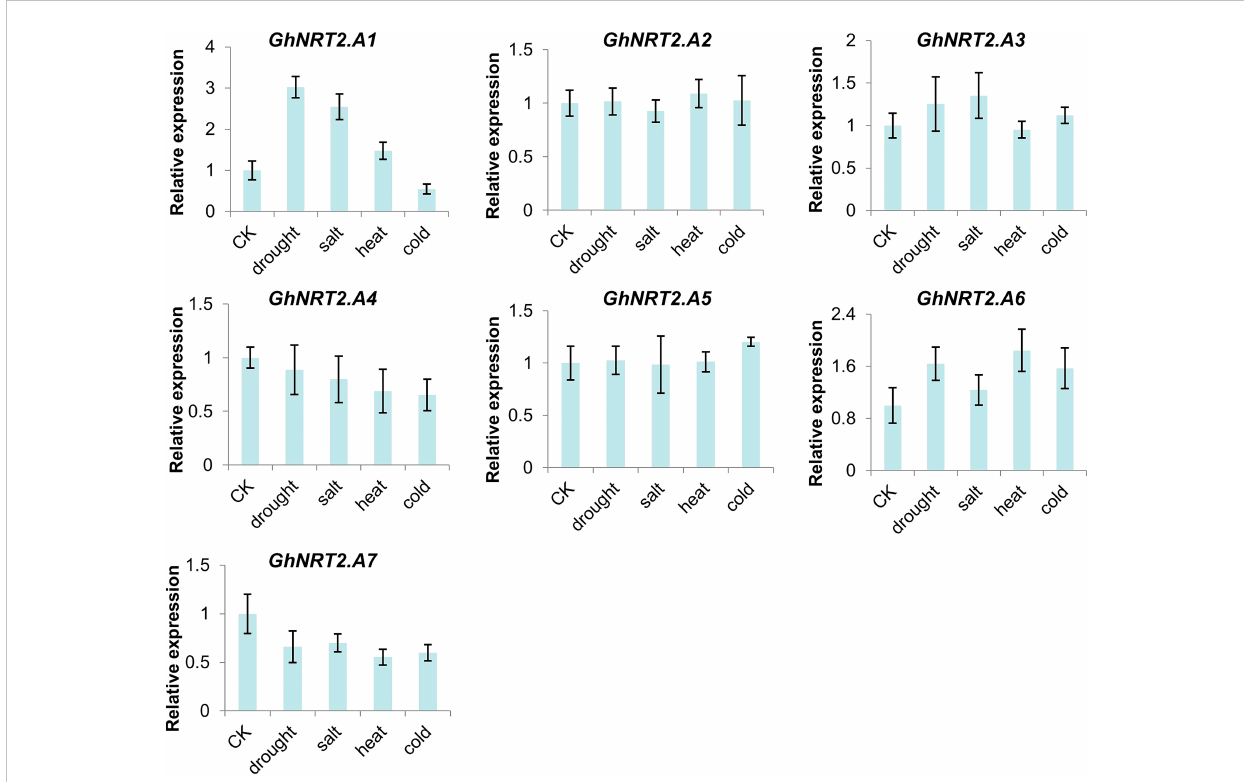
FIGURE 8 The expression of GhNRT2.A1-A7 in different treatments. The qRT-PCR result of GhNRT2.A1-A7 in root of G.hirsutum treated with drought (4% PEG6000), salt (200 mM NaCl), heat (42°C), and cold (10°C). Values represent the mean ± S.D (n = 3